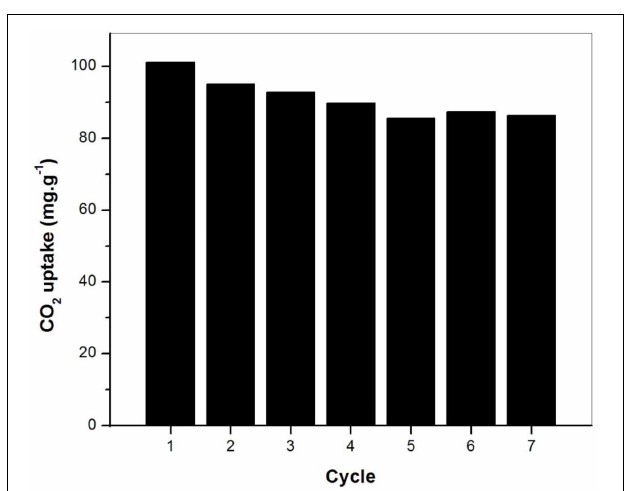
FIGURE 13 | Cyclic CO 2 sorption and desorption for